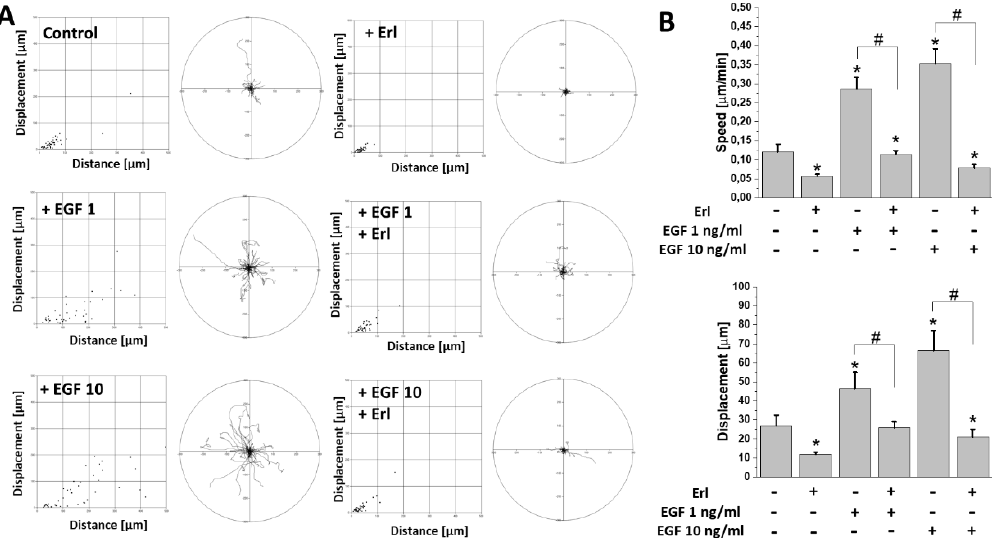
Figure 2. EGF augmented migration activity of GBM cells in vitro. ( A ) The effect of 72 h exposure of GBM cells to EGF and/or Erl. Dot plots represent displacement (X axis) and total length of trajectory (Y axis) calculated for single analyzed cells. Circular plots depict trajectories of individual cells. ( B ) Quantitative analysis of parameters (speed, displacement) describing efficiency of cells’ migration activity changes in examined conditions. Note the highly pronounced stimulation of cellular motility by EGF. Bars represent S.E.M.; n = 40. Statistical significance was calculated with non-parametric Mann–Whitney test, * p < 0.05 vs. control; # p < 0.05 vs. reference condition.